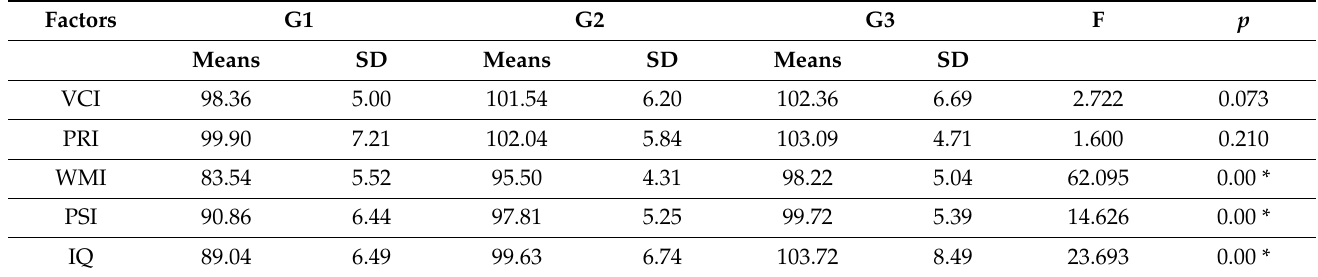
Table 1. Comparison of indices between Group 1, Group 2, and Group 3.